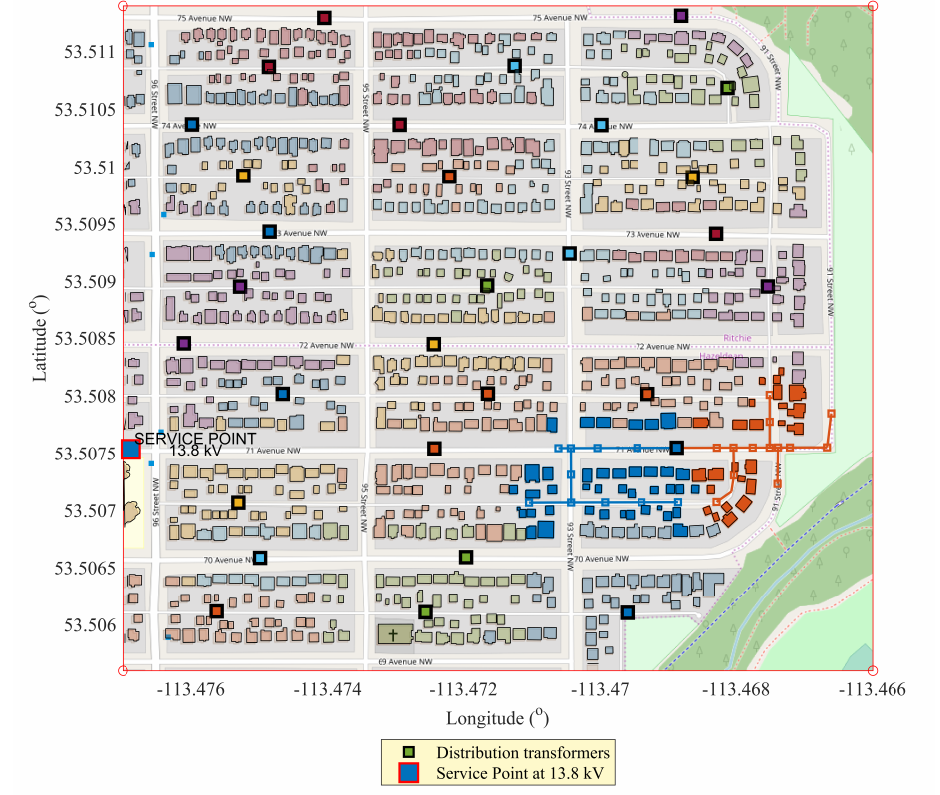
Figure 3. Case study 1: Low voltage distribution network, where distribution transformers and end users are represented with different colors depending on the